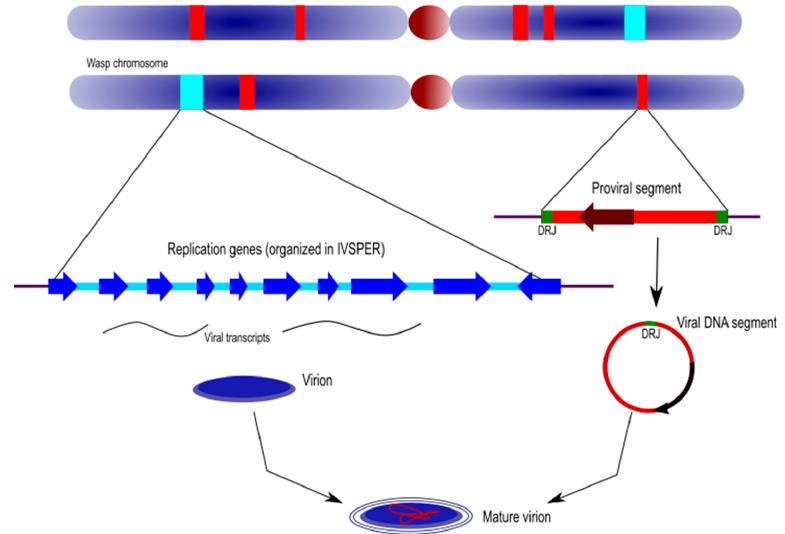
Figure 4. Genomic architecture of ichnoviruses. Ichnovirus loci are dispersed within the wasp chromosomes and comprise the proviral genome segments and the clusters of replication genes (or IVSPERs, for IV structural proteins encoding regions). The first are the linear templates of the circular molecules that are packaged in IV particles. They are flanked at each side by direct repeated sequences (named DRJ for “direct repeat junction”) allowing circularization of the molecule. The replication genes are transcribed in the wasp replicative tissue (calyx) and are involved in the production of the particle. See text for more details.